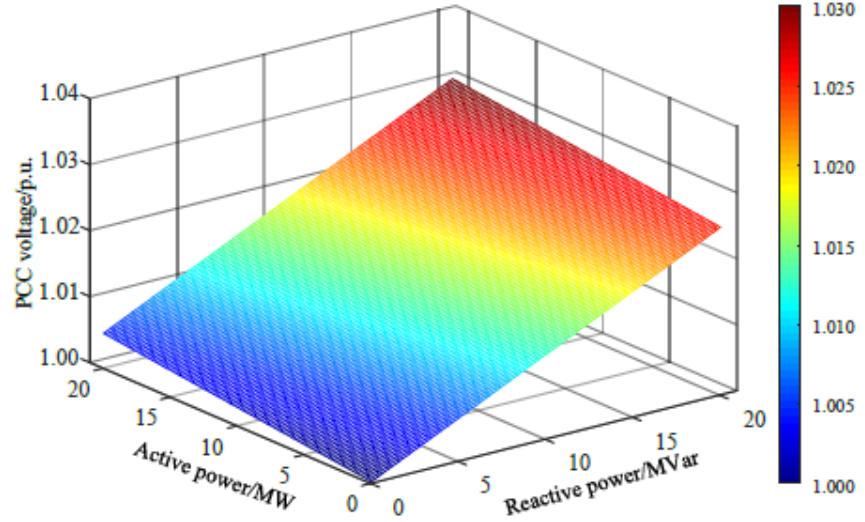
Figure 6. The PCC voltage of a wind